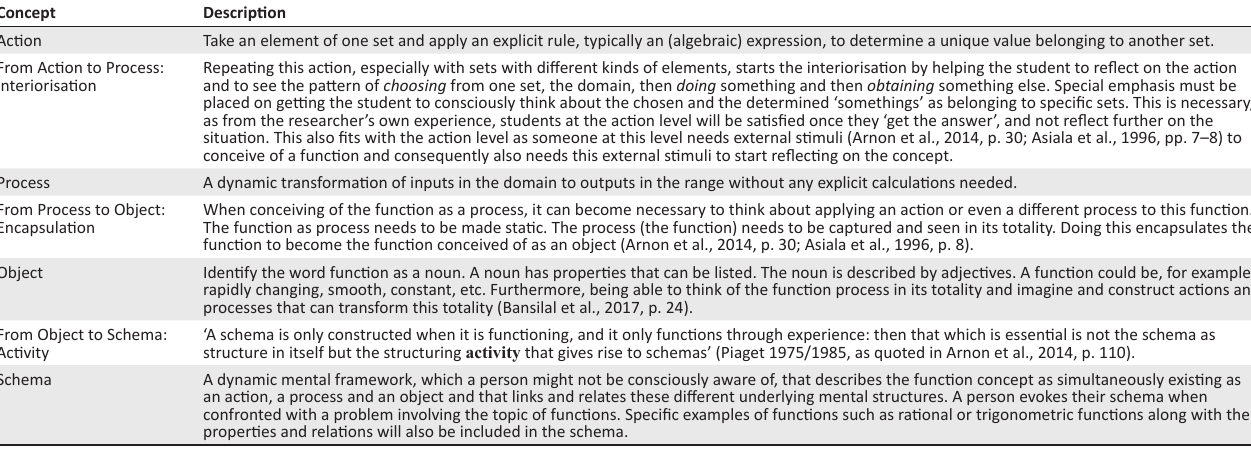
TABLE 1: Preliminary genetic decomposition of the function concept.